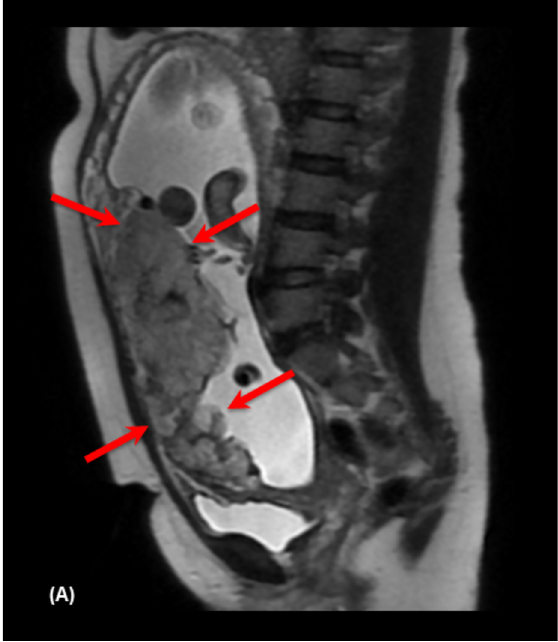
Fig. 5. 35-year-old woman at 35 weeks ' gestation and two previous C-sections. (A) Sagittal T2 weighted image shows a heterogeneous placenta